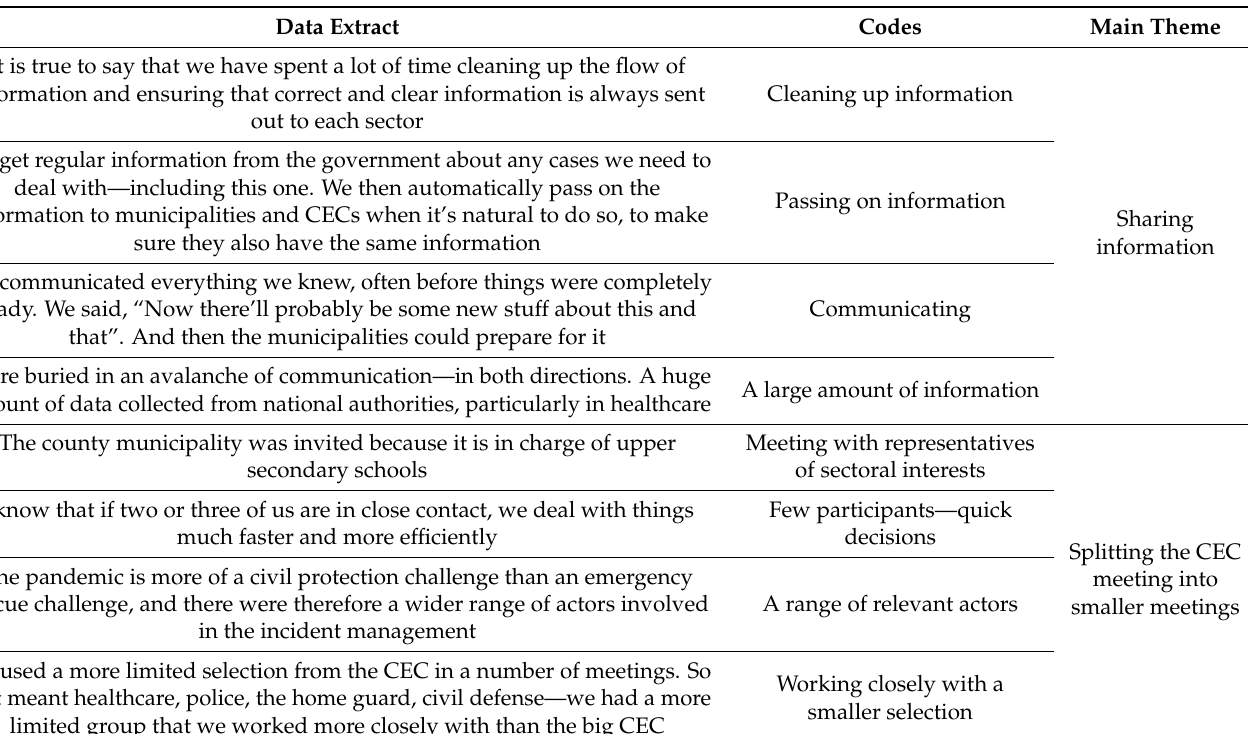
Table 1. Examples of codes and main